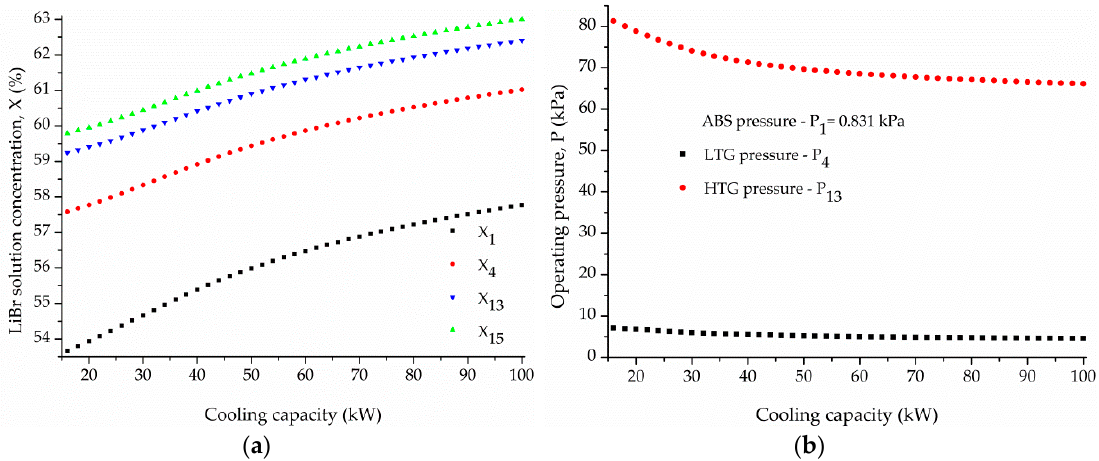
Figure 6. ( a ) Optimal LiBr concentration values of weak solution (X 1 ) and strong solutions (X 4 and X 13 leaving the LTG and HTG, respectively; and X 15 entering the ABS); ( b ) Optimal ABS (low), LTG (medium) and, HTG (high) operating pressure values, versus the cooling capacity level.